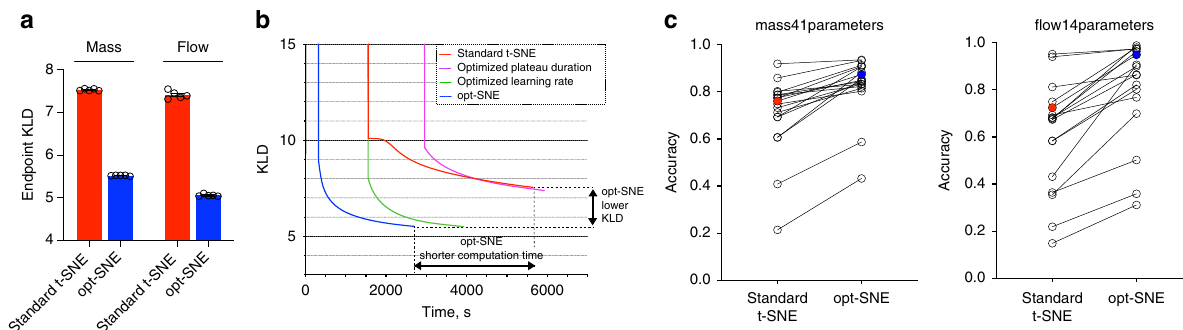
Fig. 5 Evaluation of opt-SNE embeddings. a Endpoint KLD values for standard t-SNE (initial learning rate step = 200, EE stop = 250 iterations) and opt-SNE (initial learning rate = n/ α , EE stop at maxKLDRC iteration). N = 5 seeds used for random initialization; error bars denote SEM. b Post-EE graph of KLD minimization over physical time for standard t-SNE, adjusted parameter (as indicated) t-SNE and opt-SNE (representative examples of mass cytometry data embeddings are shown). c 1NN accuracy scores for standard t-SNE and opt-SNE embeddings of of mass cytometry (left) and fl ow cytometry (right) data per assigned class values (cell subsets, open circles; overal scores, fi lled circles). Representative examples of multiple runs initiated with varying seed values